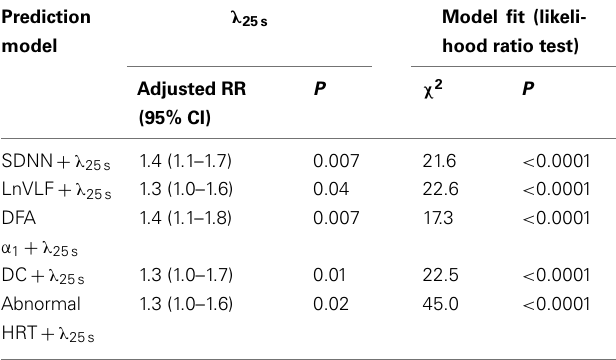
Table 4 | Independent relative risk of λ 25s for post-AMI cardiac mortality.